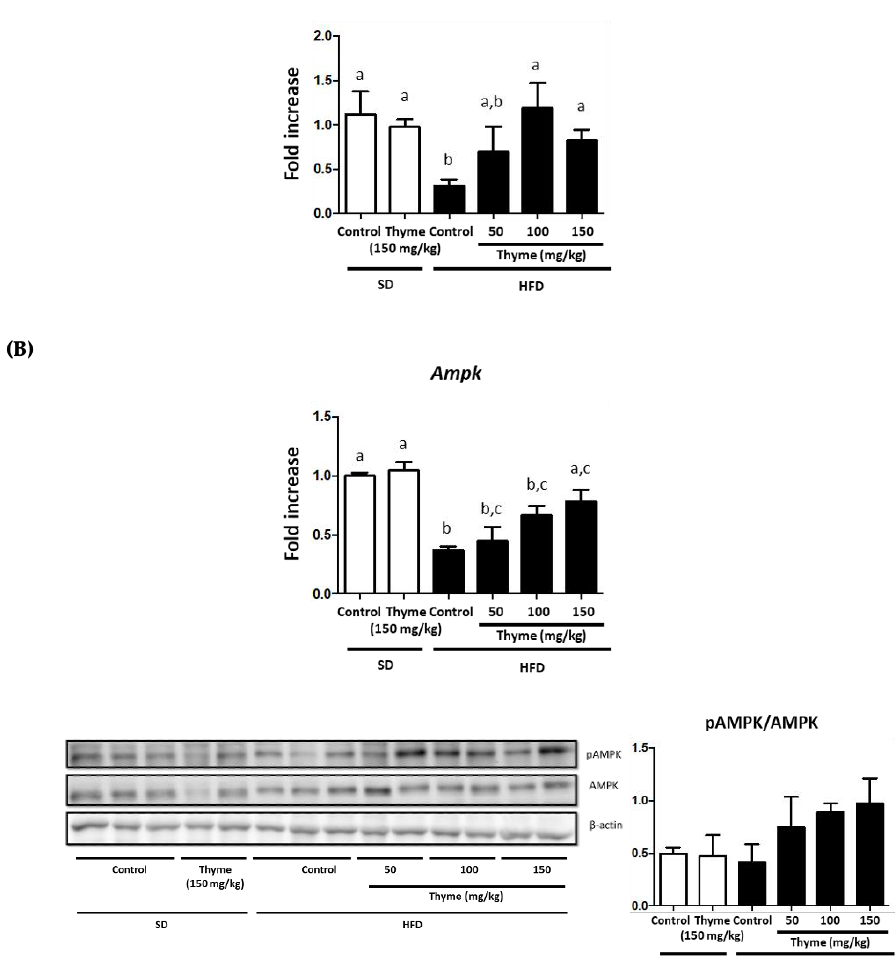
Figure 7. Effects of Thyme extract administration on: ( A ) gene expression of Glut2 in liver and ( B ) AMPK gene expression and pAMPK/AMPK ratio evaluated by Western blot. Data are expressed as means ± SEM ( n = 10). Groups with different letters statistically differ ( p < 0.05).